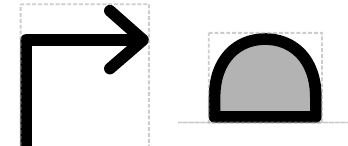
Figure 2: Examples of glyph specification: this specification for the sequence feature glyphs for Promoter (left) and Ribosome Entry Site (right) include the glyph outline, fill (grey center of Ribosome Entry Site), bounding box (dashed box), and recommended alignment with the nucleic acid backbone (dashed horizontal line), all at a preferred relative